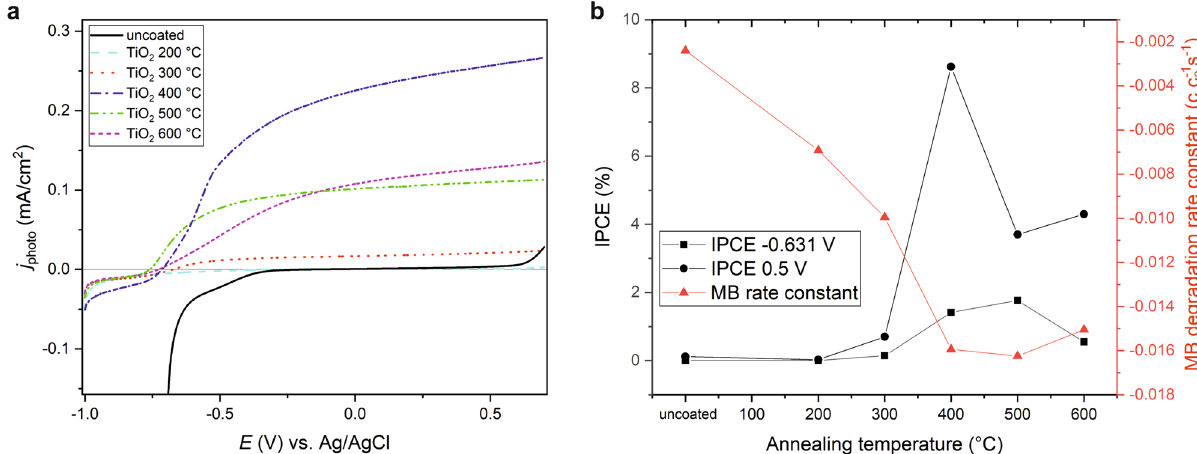
Figure 5. ( a ) Linear sweep voltammetric curves of neat and TiO 2 -coated FTO glass slides recorded under 369 nm irradiation at 100 W ∕ m 2 . ( b ) Incident photon conversion efficiencies (IPCE) of the samples as calculated for the potentials of 0.5 V and − 0.631 V versus Ag/AgCl, respectively, and methylene blue degradation rate constants for comparison. The drawn lines in ( b ) serve as guide to the